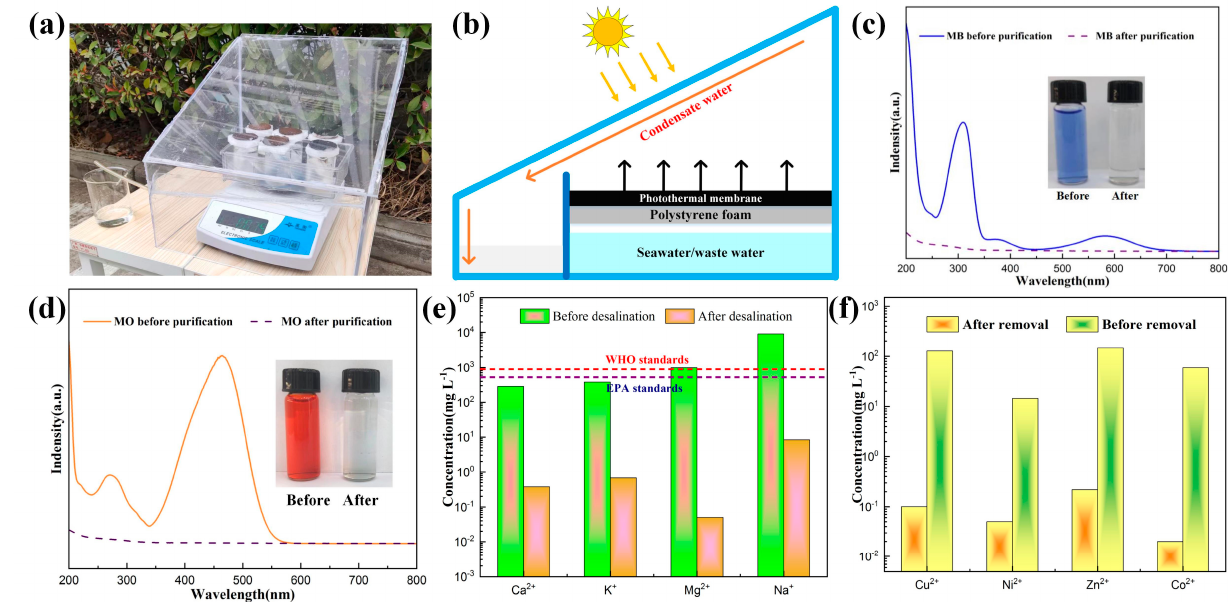
Figure 7. ( a ) Physical map of the SSG apparatus for outdoor measurements. ( b ) Schematic diagram of the outdoor SSG apparatus. ( c ) Solar absorption spectra before and after MB solution purification; inset shows the photos before and after MB solution purification. ( d ) Solar absorption spectra before and after MO solution purification; inset shows the photos before and after MO solution purification. ( e ) Comparison of ion concentrations in a simulated seawater solution before and after desalination. ( f ) Comparison of the concentrations of heavy metal ions in the sewage solution before and after purification. Table 1. Concentrations of Ca 2+ , K + , Mg 2+ , and Na + ions in solutions before and after desalination.